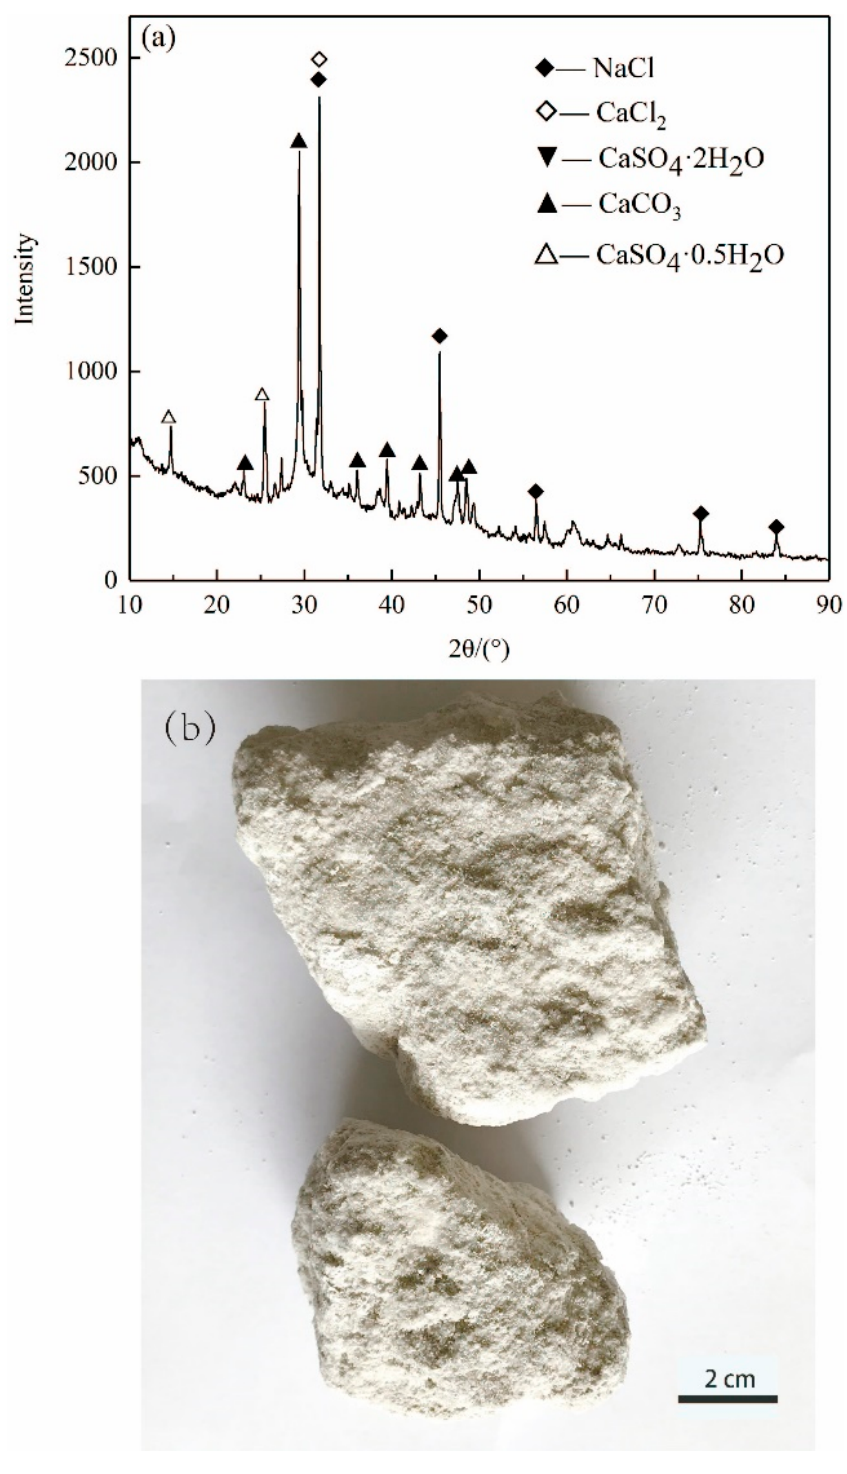
Figure 1. ( a ) XRD pattern and ( b ) photo of ASR.